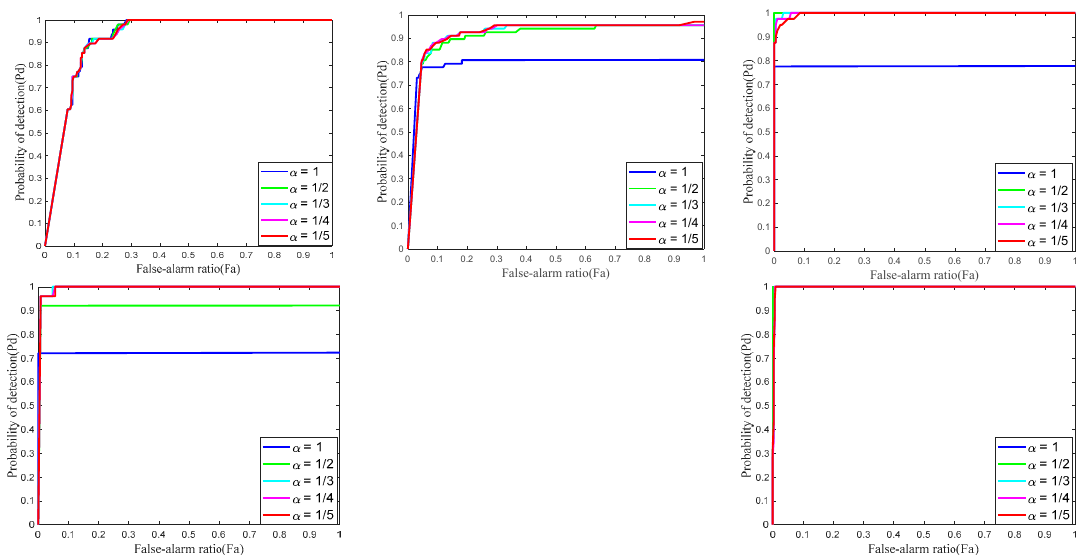
Figure 6. Detection performances under different parameters. Rows 1–2: ROC curves with respect to different penalty factors, Rows 3–4: ROC curves with respect to different norm factors, Rows 4–5: ROC curves with respect to different compromising constants.